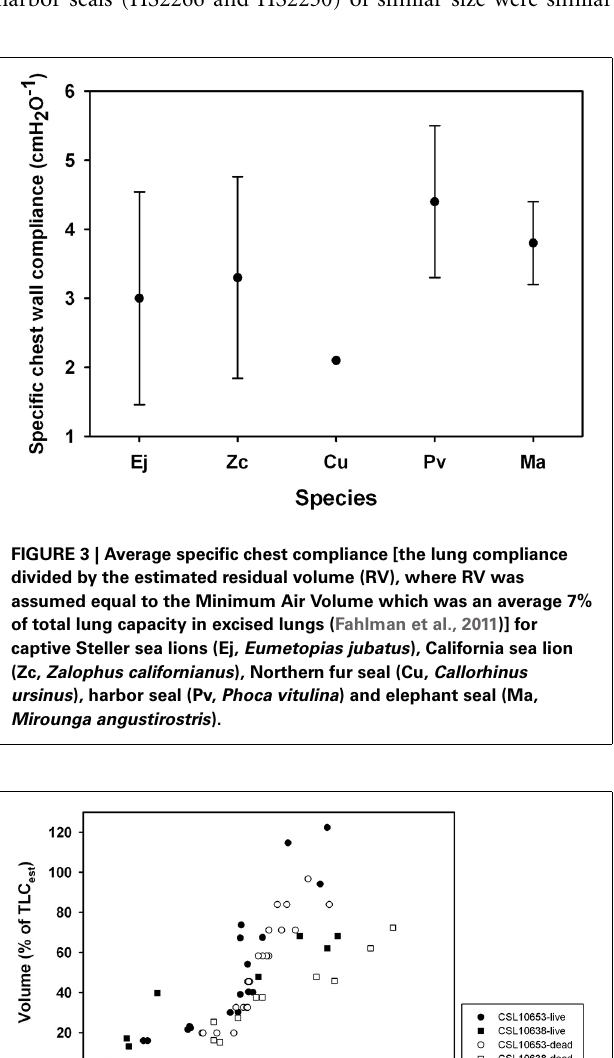
FIGURE 2 | Average specific lung compliance [the lung compliance divided by the estimated residual volume (RV), where RV was assumed equal to the Minimum Air Volume which was an average 7% of total lung capacity in excised lungs (TLC = 0.135 × Mb ∧ 0.92, Kooyman, 1973; Fahlman et al., 2011)] for captive Steller sea lions (Ej = Eumetopias jubatus ), California sea lion (Zc = Zalophus californianus ), Northern fur seal (Cu = Callorhinus ursinus ), harbor seal (Pv = Phoca vitulina ) and elephant seal (Ma = Mirounga angustirostris ).